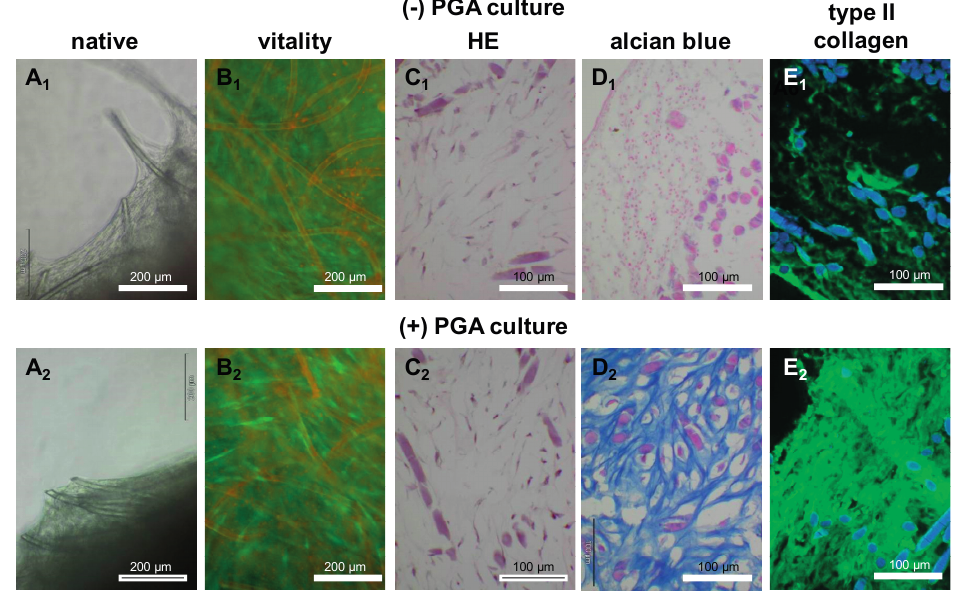
, A ) Invert microscopical pictures 1 2 , B ) 1 2 , E ). In the HE 1 2 – B ), 100 µm ( C – E ). 1 2 1 2 type II collagen(-) PGA culture HE alcian blue